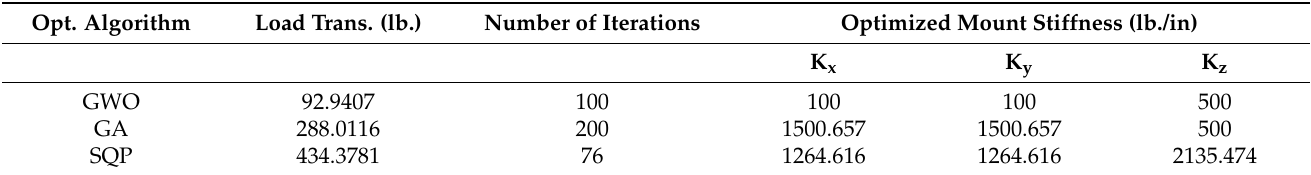
Table 7. Optimized mounts’ stiffness (12-DOF model—combined loading).